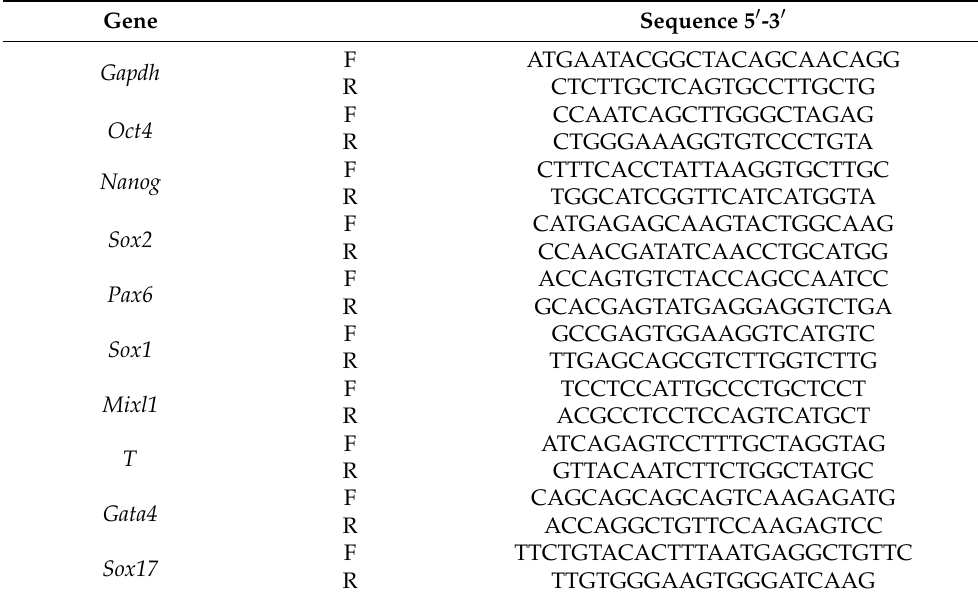
Table 1. Gene-specific primer sequences for real-time reverse transcription polymerase chain reac- tion